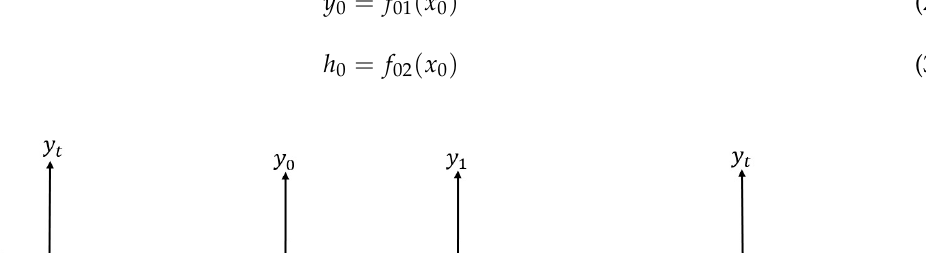
Figure 4. General architecture of a stacked CNN-RNN network for temporal image extraction.